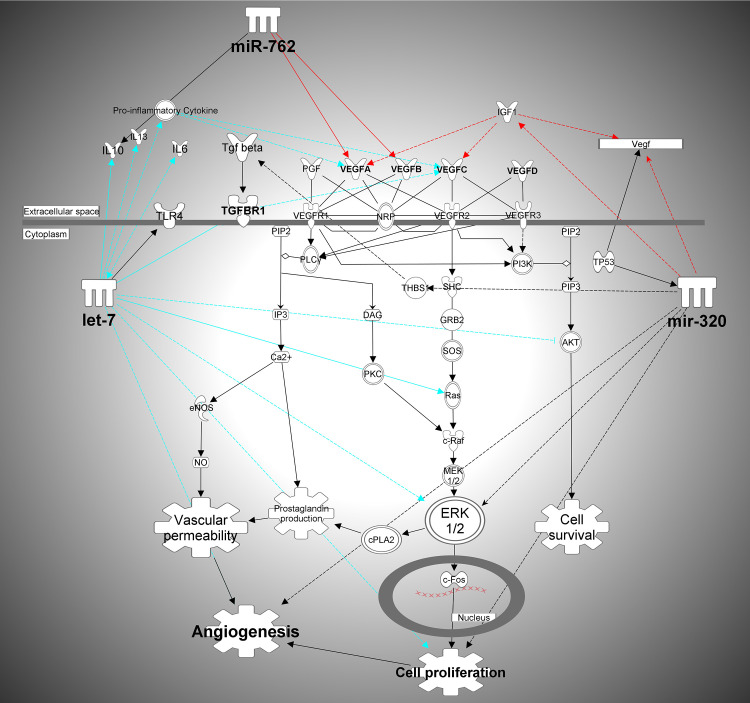
IPA analysis of pathways targeted by both let-7 and miR-320 family as identified pathways connecting VEGF and TGF-beta.